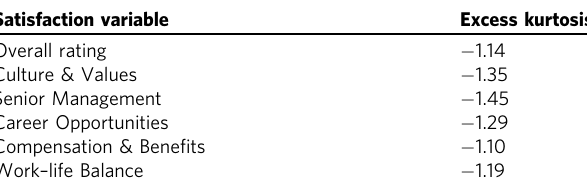
Table 7 Excess kurtosis of Glassdoor employee satisfaction numerical ratings to address reviews ’ polarization